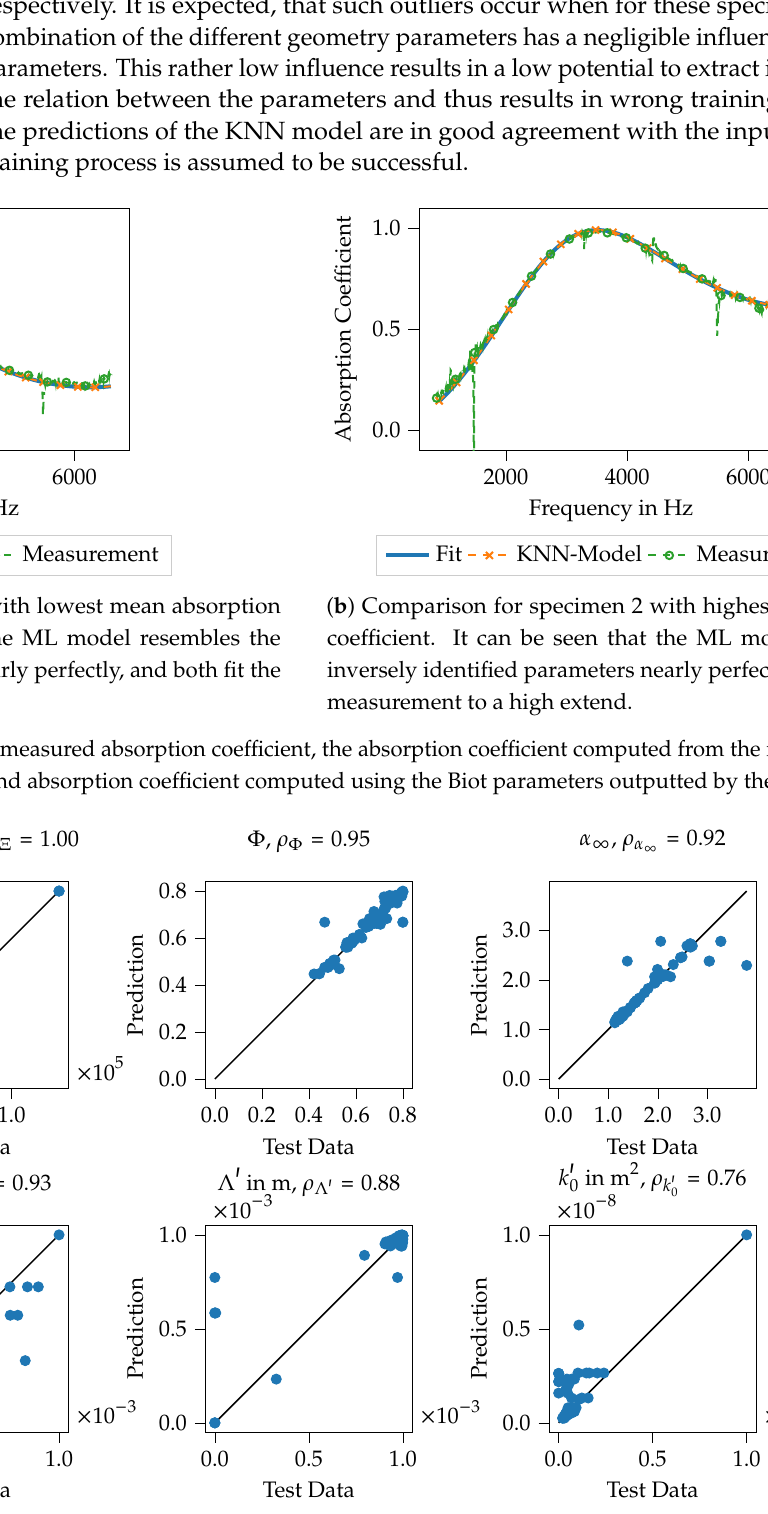
Figure 11. Correlation graphs for inversely identified Biot parameters and their corresponding prediction by the KNN model. It can be seen that all quantities are predicted with reasonable accuracy, thus the model is qualified for further